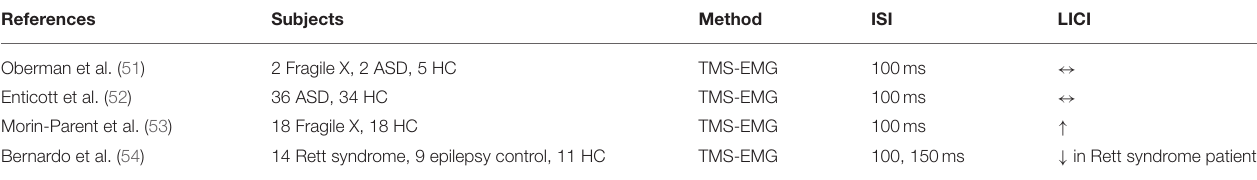
TABLE 4 | LICI in patients with neurodevelopmental disorders.